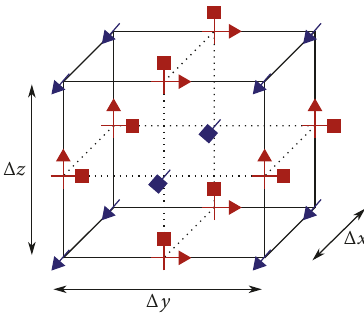
Figure 1: The UCHIE cell for implicitization and collocation in the 𝑥 -dimension. Triangular arrows denote electric field components and squarearrows magnetic field components. Blue and red markers are staggered in time.